Question: Write a single sentence explaining what this figure depicts.
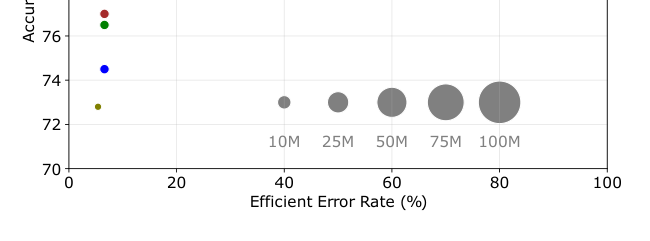
Answer: Graphical comparison of KD model Top-1 accuracies and EER values on the ImageNet-1K dataset. The area of bubbles corresponds to the number of trainable parameters (#Param). The reference #Param sizes (from 10M to 100M) are shown in gray in the bottom right corner.